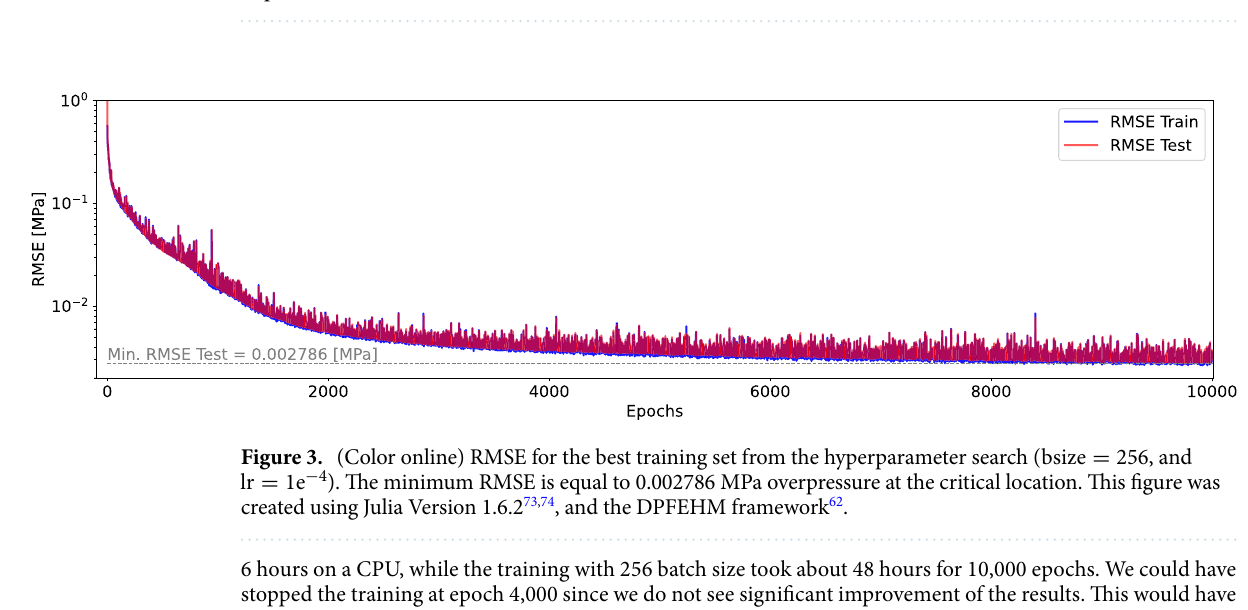
Table 2. Hyperparameter search to determine the optimal ML parameters. Minimum testing RMSE for a variety of batch sizes, bsize ∈ [ 32, 64, 128, 256 ] ; and learning rates, lr ∈ [ 1e − 3 , 3e − 4 , 1e − 4 ] . The results are given in pressure units [MPa].